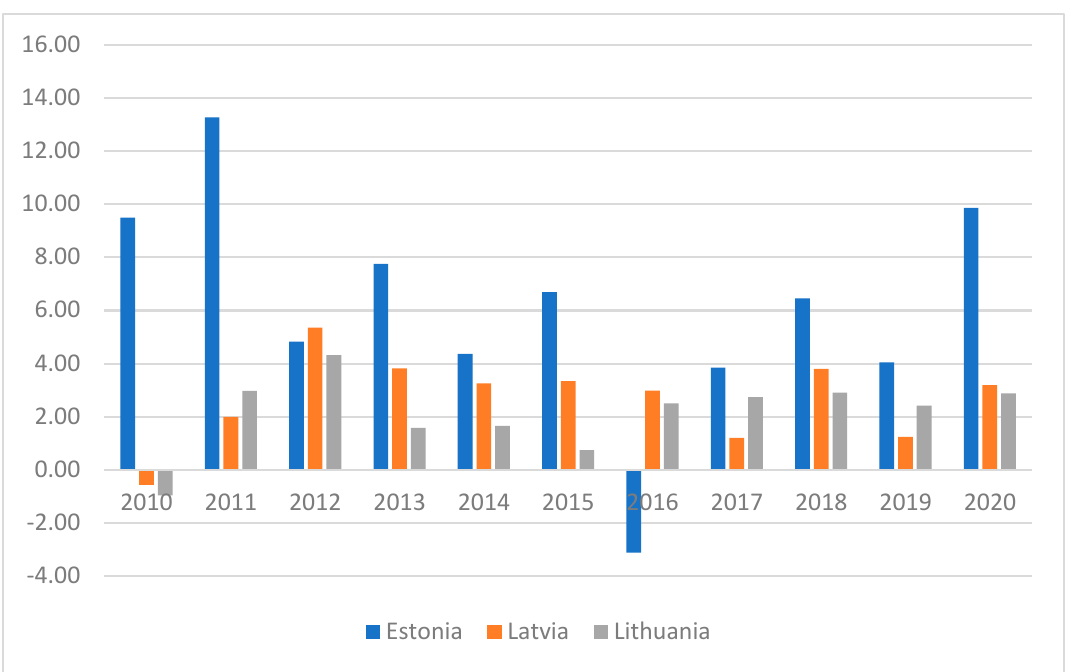
Figure 2. GDP per capita dynamics in the Baltic states over the period of 2010–2020.